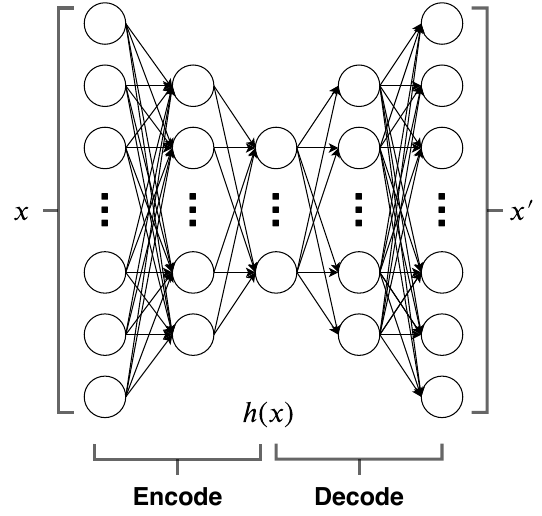
Figure 1. Autoencoder